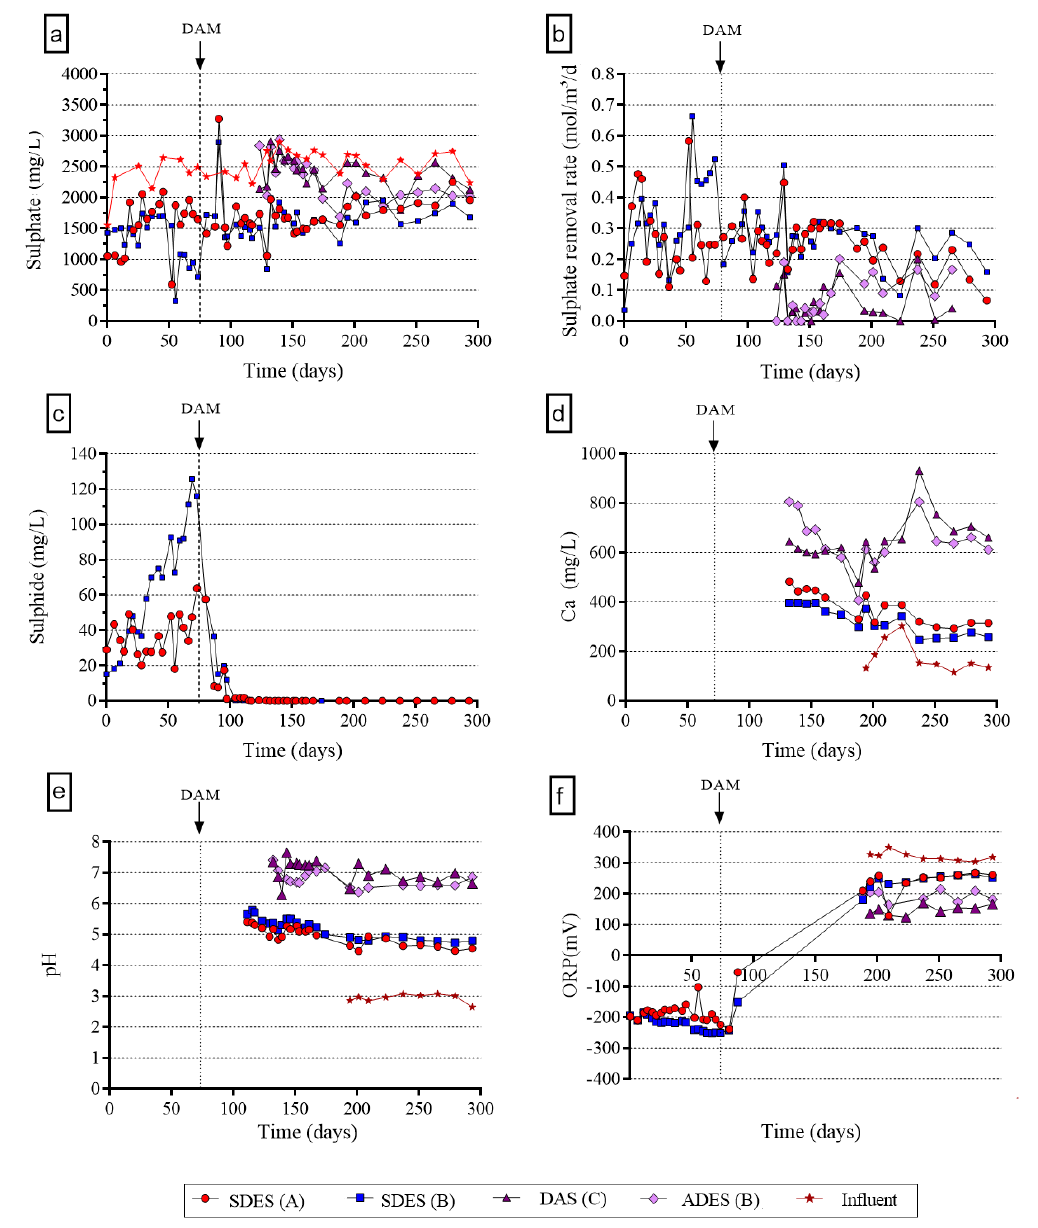
Figure 2. Evolution of critical variables during the experiment: ( a ) effluent sulfate; ( b ) sulfate removal rate; ( c ) effluent sulfide; ( d ) effluent calcium; ( e ) effluent pH; ( f ) effluent ORP (E Ag/AgCl ).